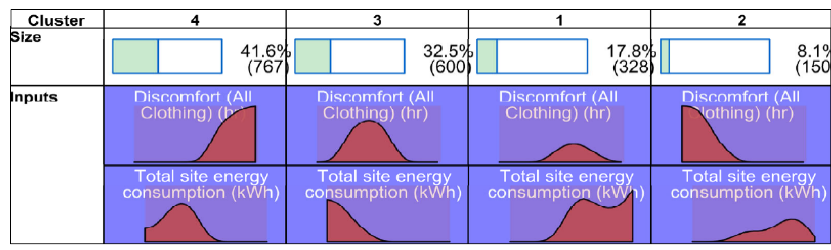
Figure 18. Cluster specification for each group .